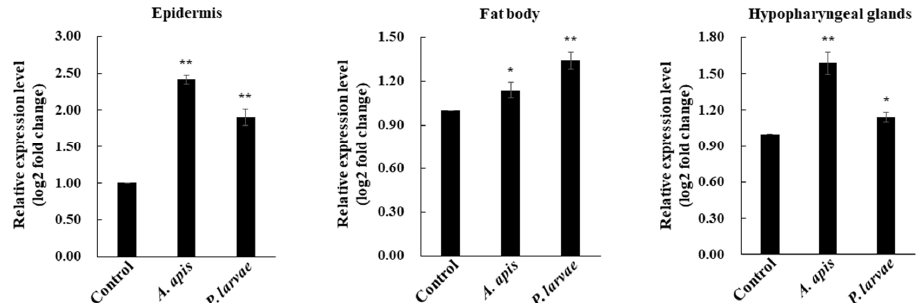
Figure 2. Transcription pattern of Apis mellifera apidermin 2 ( AmAPD 2 ) in A. mellifera worker bees upon microbial ingestion. The transcription pattern of AmAPD 2 was analyzed in A. mellifera worker bees fed A. apis or P. larvae over 24 h. Untreated A. mellifera worker bees were used as controls. Total RNA was extracted from the epidermis, fat body, and hypopharyngeal glands of A. mellifera worker bees ( n = 40). AmAPD 2 transcription was analyzed using quantitative reverse transcription-PCR (qRT-PCR). Data are represented as the mean ± standard deviation (SD) of three replicates (* p < 0.05 and ** p < 0.01).